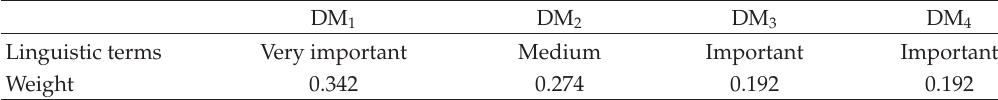
Table 2: The importance of DMs and their